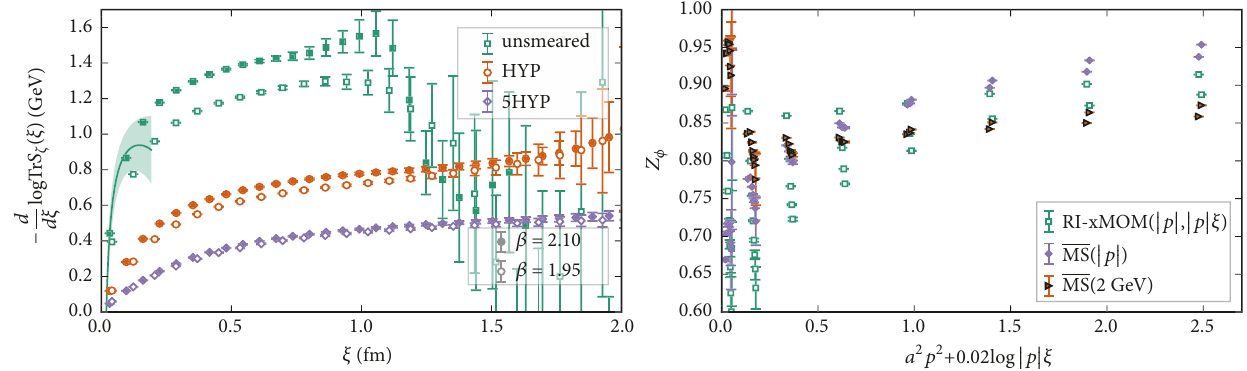
Figure 17: Left: Equation (81) for two lattice spacings with solid (open) symbols corresponding to the finer (coarser) lattice spacing. The curve shows the three-loop perturbative result, shifted vertically by −𝑚 to match the unsmeared data on the finer lattice spacing. Right: 𝑍 𝜙 for 𝛽 = 2.10 , using unsmeared gauge links, for a range of 𝑝 2 and 𝑦 ≡ |𝑝|𝜉 ; the horizontal axis is 𝑎 2 𝑝 2 . The green open squares/ blue filled diamonds/ orange filled triangles show results in RI-xMOM / MS( |𝑝| )/ MS(2GeV). Source: [186], reprinted with permission by the